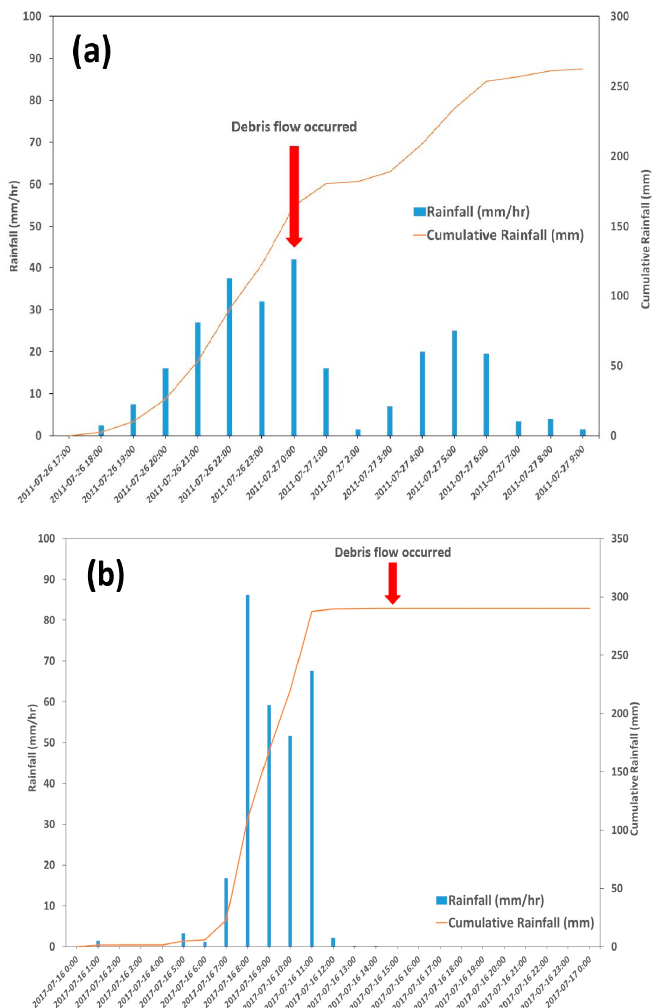
Figure 2. Analysis of rainfall events (hourly rainfall and accumulated rainfall) changing before and after the occurrence of debris flows in the study areas (source: data from the Korea Meteorological Administration): ( a ) Analysis of rainfall events from 26 to 27 July 2011, with the reference point as the debris flow occurrence in Chuncheon-shi, Gangwon-do; and ( b ) Analysis of rainfall events from 16 to 17 July 2017, with reference point as the debris flow occurrence in Cheongju-shi, Chungcheongbuk-do.